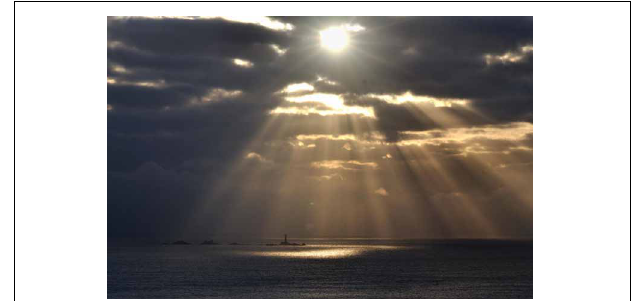
FIGURE 2 | The sunbeam illusion or crepuscular rays. The sun shines through clouds creating regions of illumination and shadow. The beams appear to radiate from a central point much as the blades of a fan emanate from a center. The perceptual effect is striking in the natural environment when the viewer looks with one eye while not moving the head. Image: Andrew Green “over the lighthouse,” December 13, 2010 via Flickr, Creative Commons